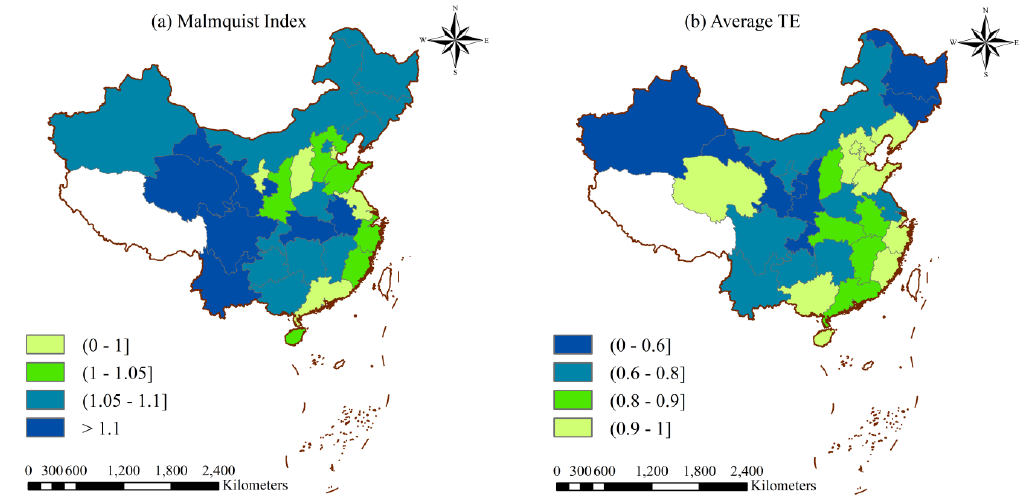
Figure 4. Horizontal interval distribution of ( a ) Malmquist index and ( b ) average TE in China (2007–2017).